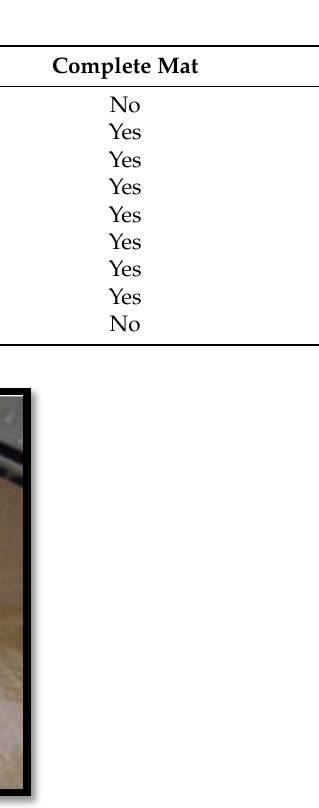
Figure 5. Fibre clumps formed on the wire mesh covering the rotating drum of the dynamic sheet former.